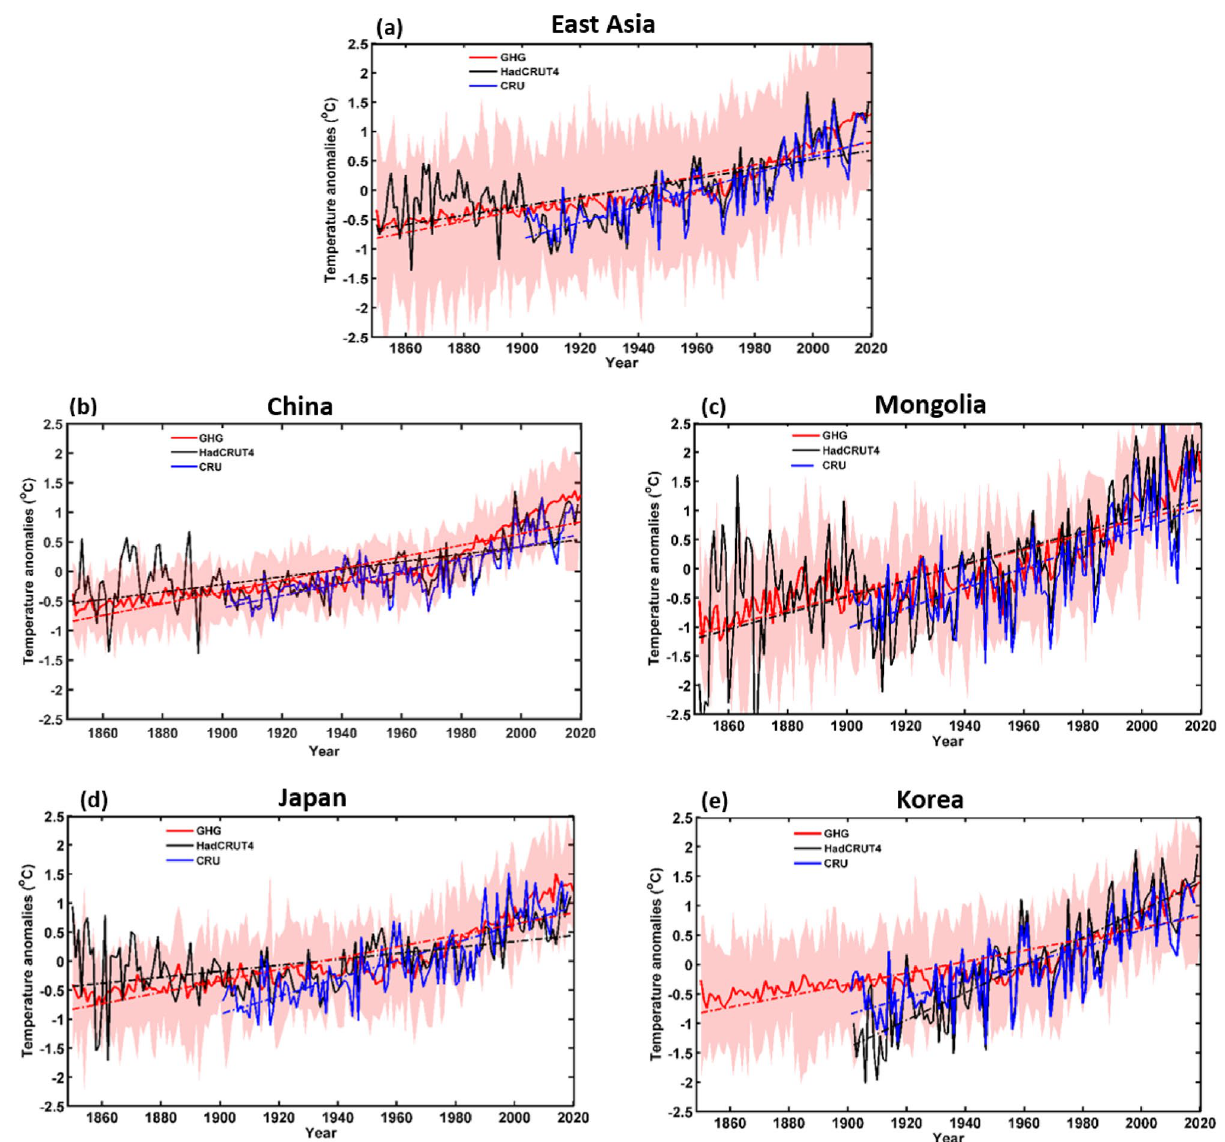
Figure 4. As for Fig. 3 but showing temperature anomaly responses to GHG